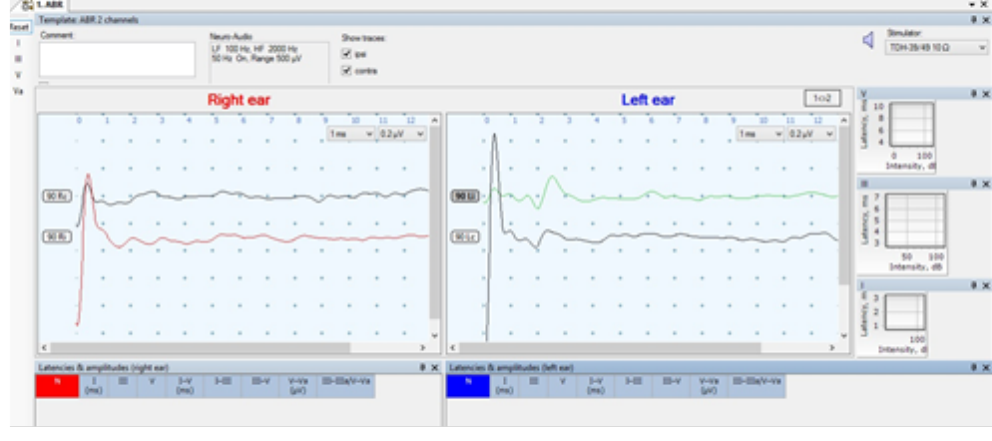
Fig. 3 Bilateral deafness.